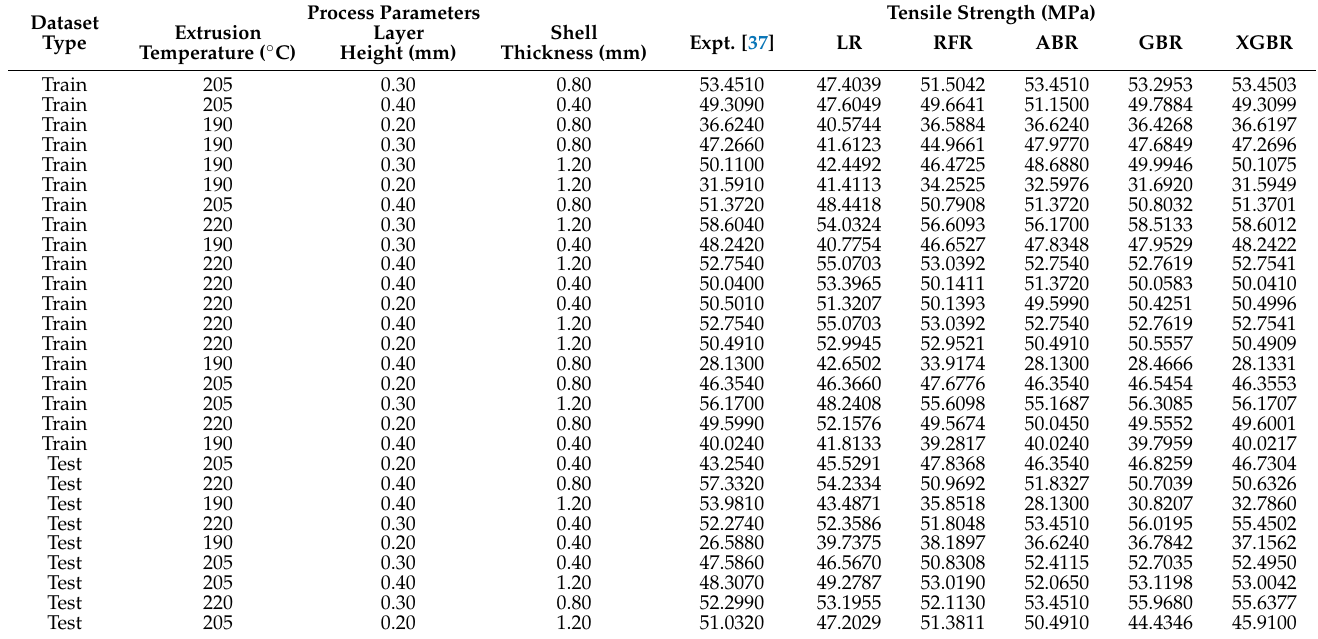
Figure A1. ( a ) CAD model of test specimen; ( b ) 3D printed specimen [7]. Table A1. Predicted tensile strength values by different ML algorithms for case study 1.